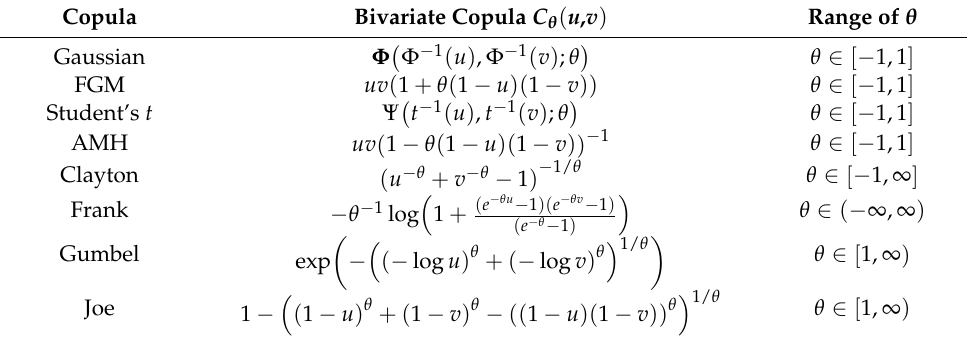
Table 1. Distribution functions of